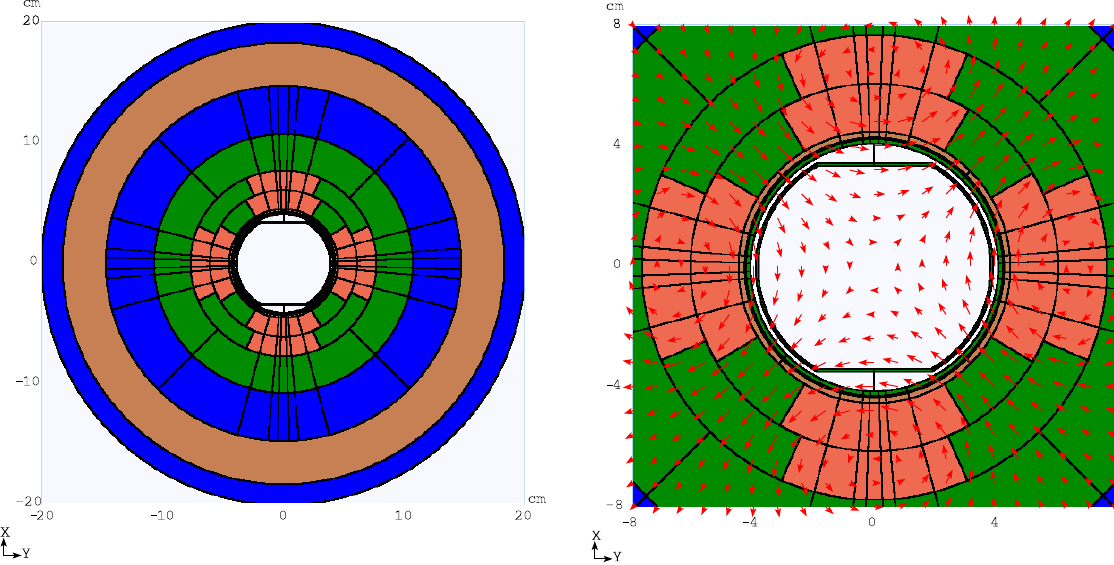
FIG. 3. (Color) MARS15 geometry model of a 90-mm Nb details as well as magnetic field distribution